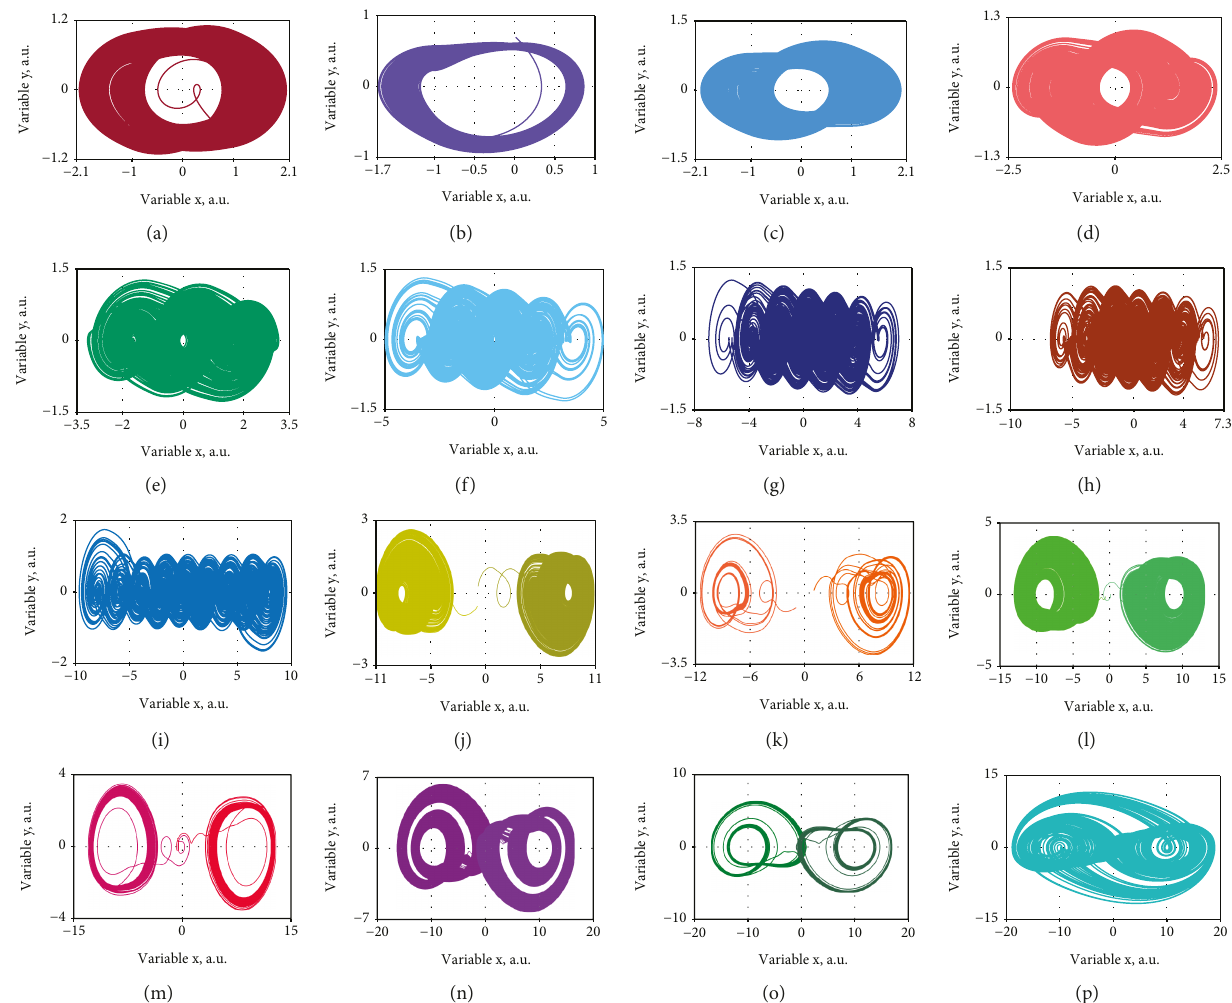
Figure 5: Space phase for each attractor identi fi ed into the bifurcation diagram, Figure 4, for the control parameter α = 0 45